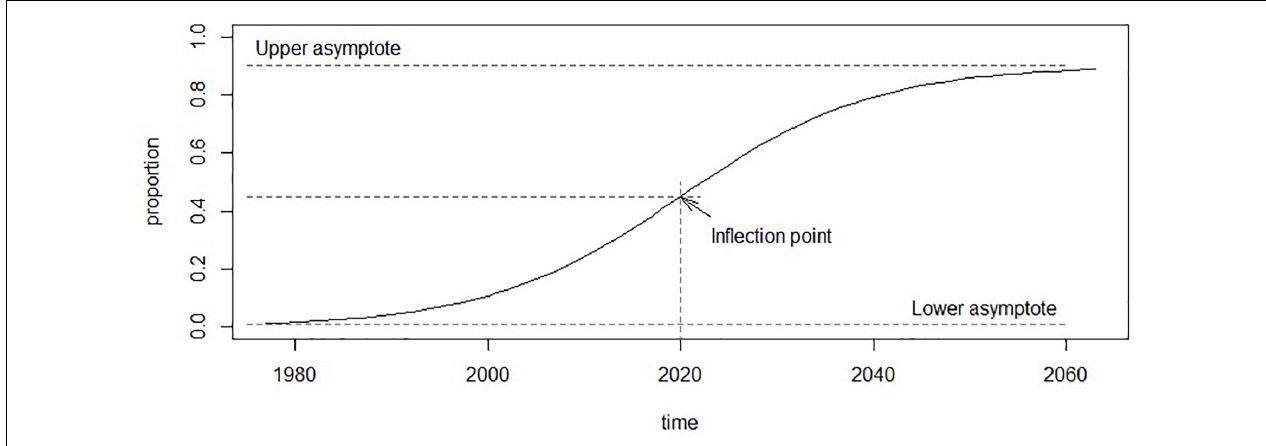
FIGURE 1 | Generalized sigmoid function, with the upper and lower asymptote and the inflection point marked. The logistic function is used to draw the